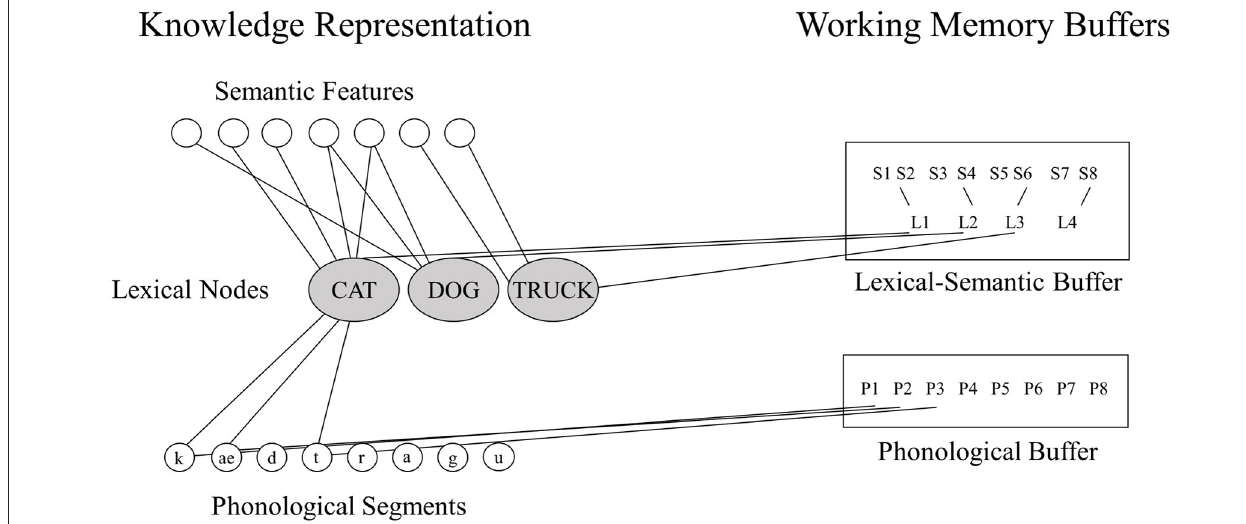
they found the reverse pattern of sensitivity to word frequency but not length in the left inferior frontal lobe and the left fusiform gyrus. For additional convergent findings see also (35,